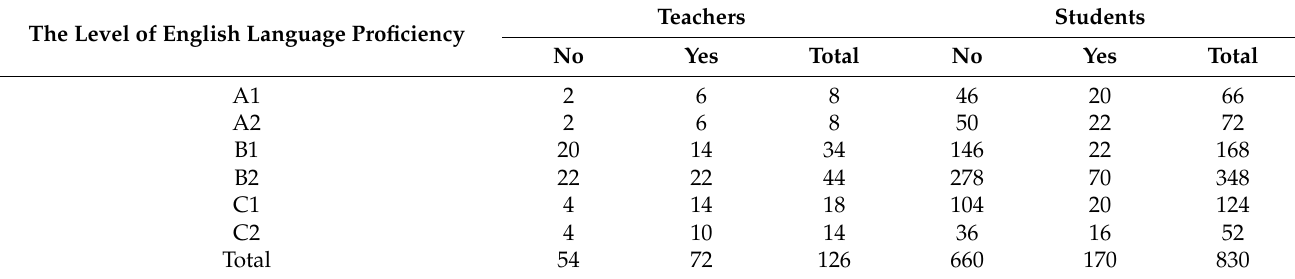
Table 3. Participation in courses or trainings related to the use of online platforms depending on the level of English language